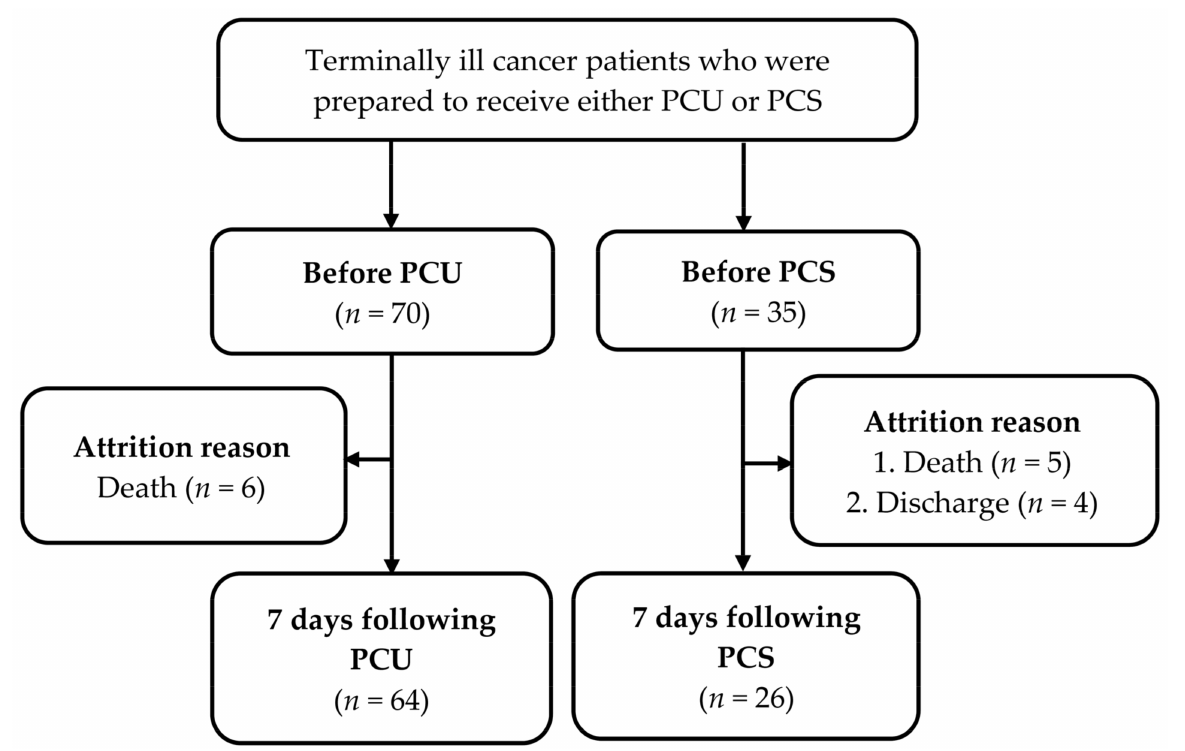
Figure 1. The study flowchart. PCU: palliative care unit; PCS: palliative consultation service. Table 1. Baseline characteristics of terminally ill cancer patients receiving inpatient hospice